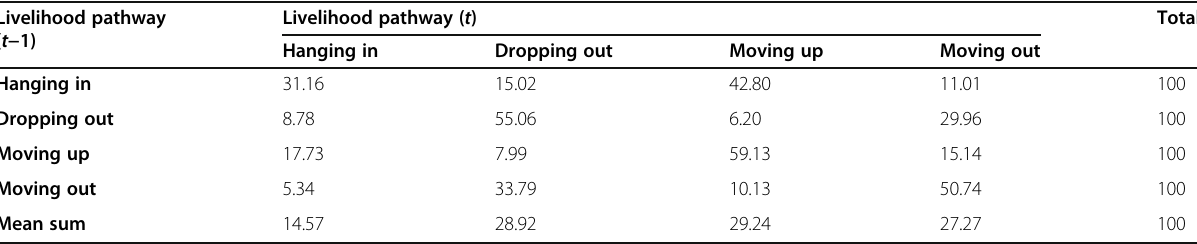
Table 5 Proportionate transitions between livelihood